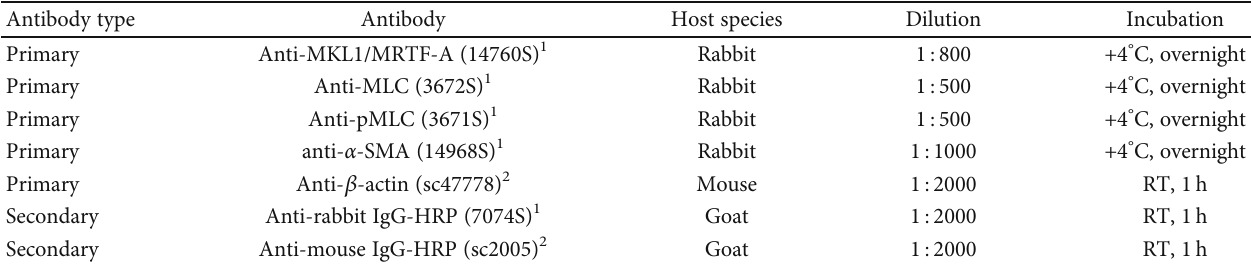
Table 2: Primary and secondary antibodies used in